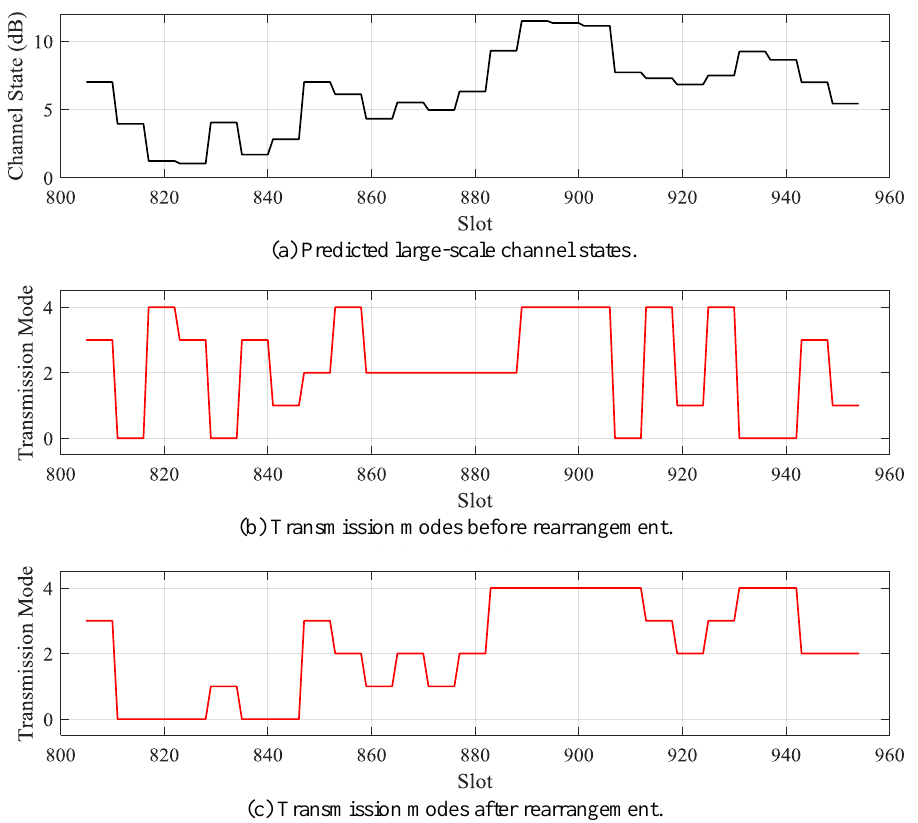
Figure 7. Rearrangement process for a transmission modes